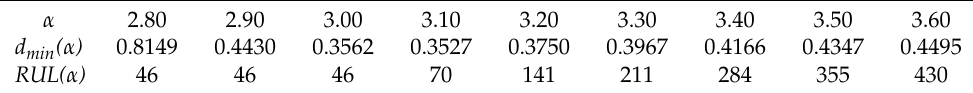
Figure 12. Similarity evaluation for RUL estimation of Bearing1-5 using Bearing1-2. Table 3. Similarity evaluation for RUL estimation of Bearing1-5 using